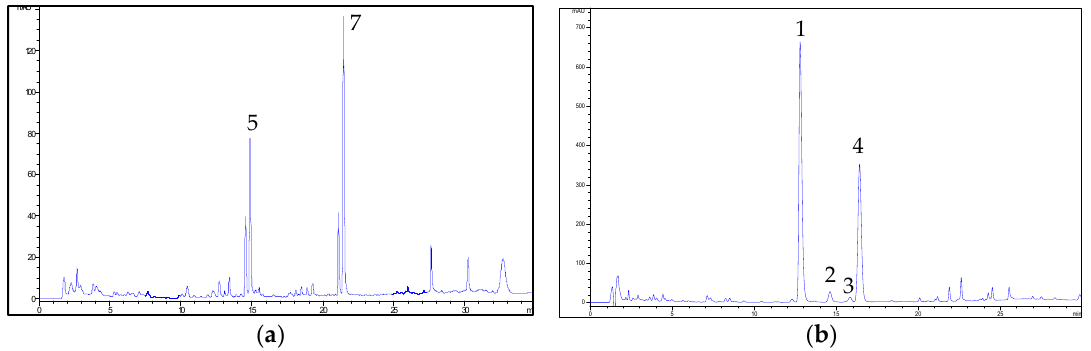
Figure 7. ( a ) Representative HPLC-UV/DAD chromatogram of a hemp extract (sample C6) at 342 nm obtained by using the analytical method optimised for flavonoids and related compounds. For peak numbering, see Table 1. ( b ) Representative HPLC-UV/DAD chromatogram of a hemp extract (sample C6) at 210 nm obtained by using the analytical method optimised for cannabinoids. For peak numbering, see Table 1.